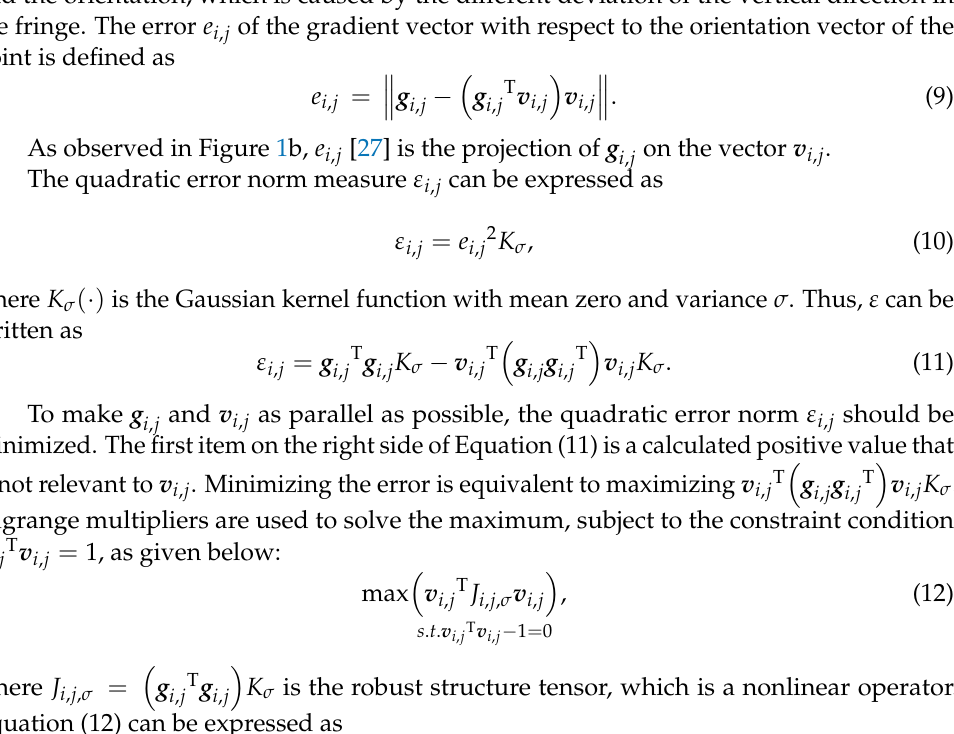
Figure 1. Orientation error diagrams. ( a ) Ideal image, ( b ) noisy image. The quadratic error norm measure